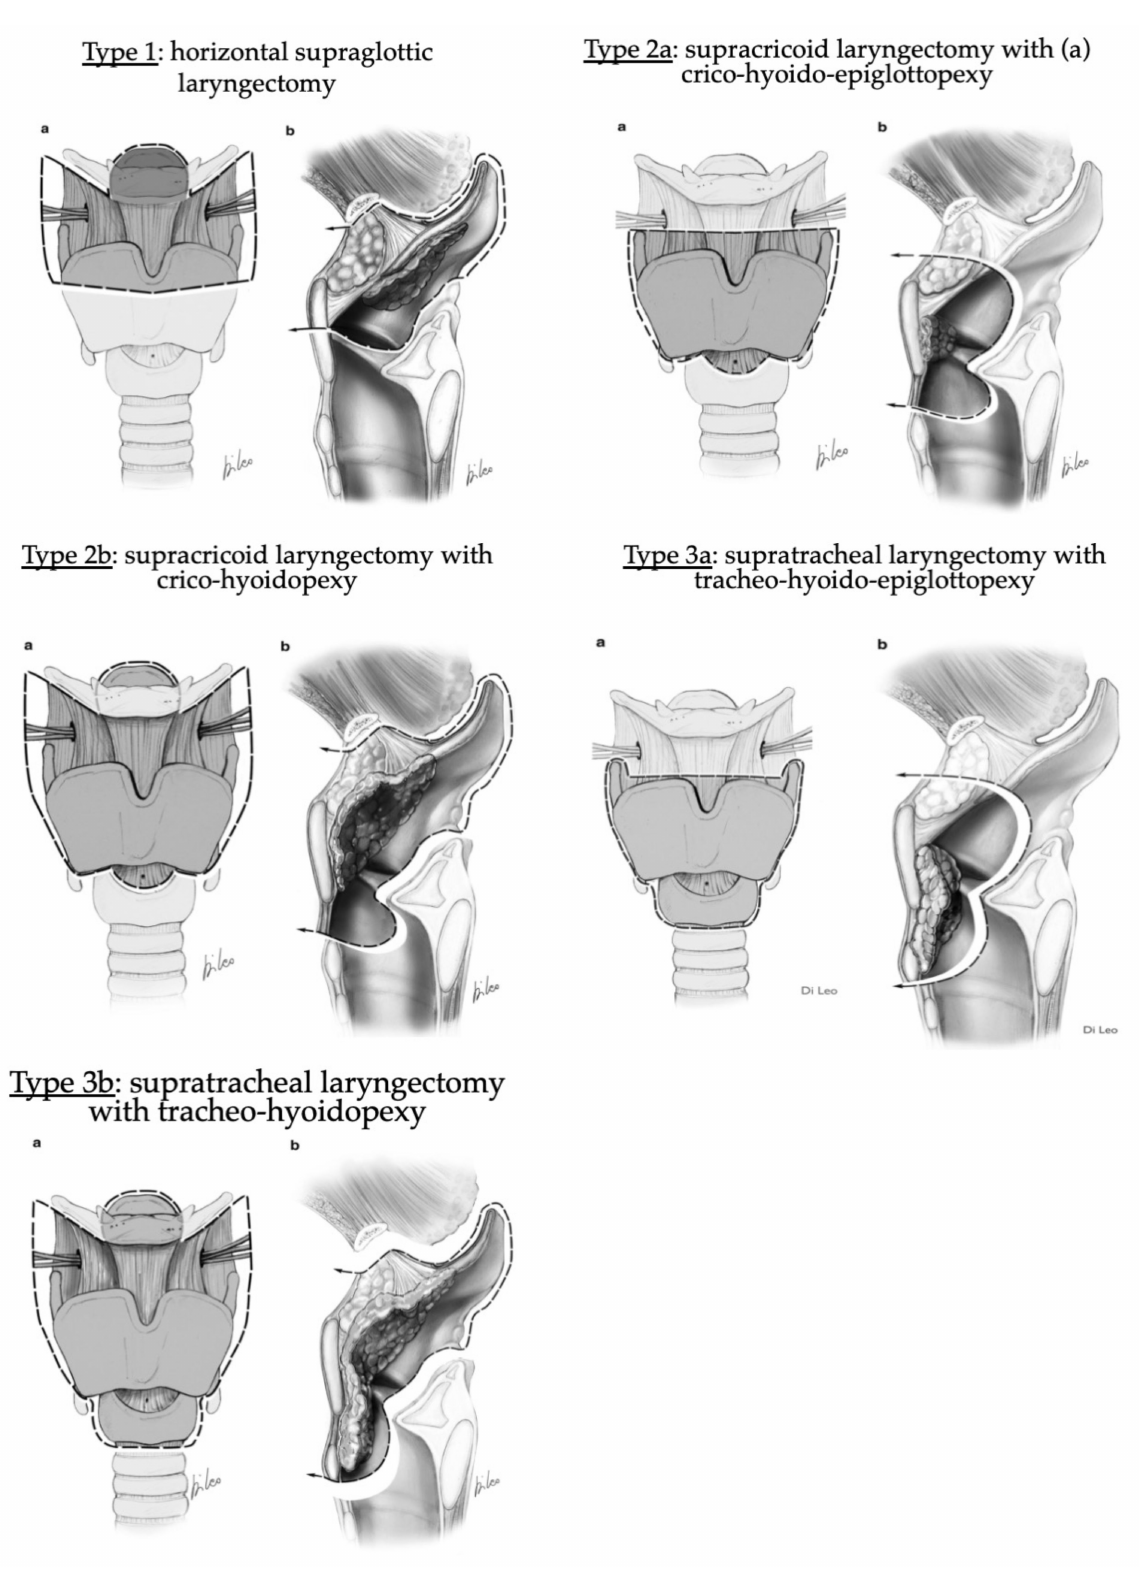
Figure 3. European Laryngological Society Classification of Open Partial Laryngectomies. Authors received the authorization of Pr. Marc Remacle to re-use the picture